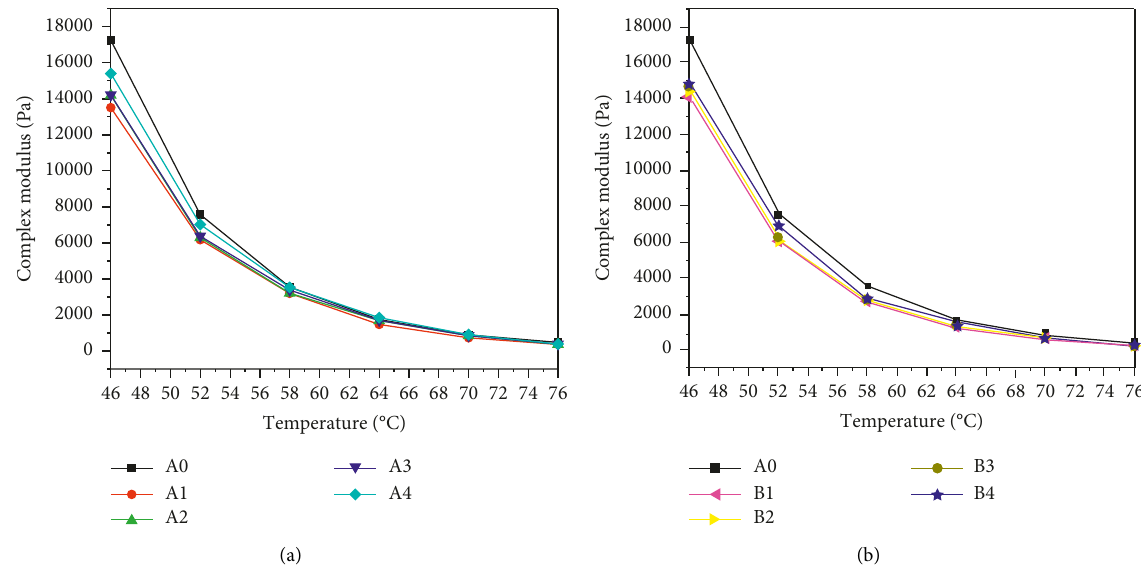
Figure 7: Complex modulus of GOMBA at different dosage levels. (a) Effects of different dosage levels of GO on the complex modulus of bio-asphalt A and (b) effects of the different dosage levels of GO on the complex modulus of bio-asphalt B.